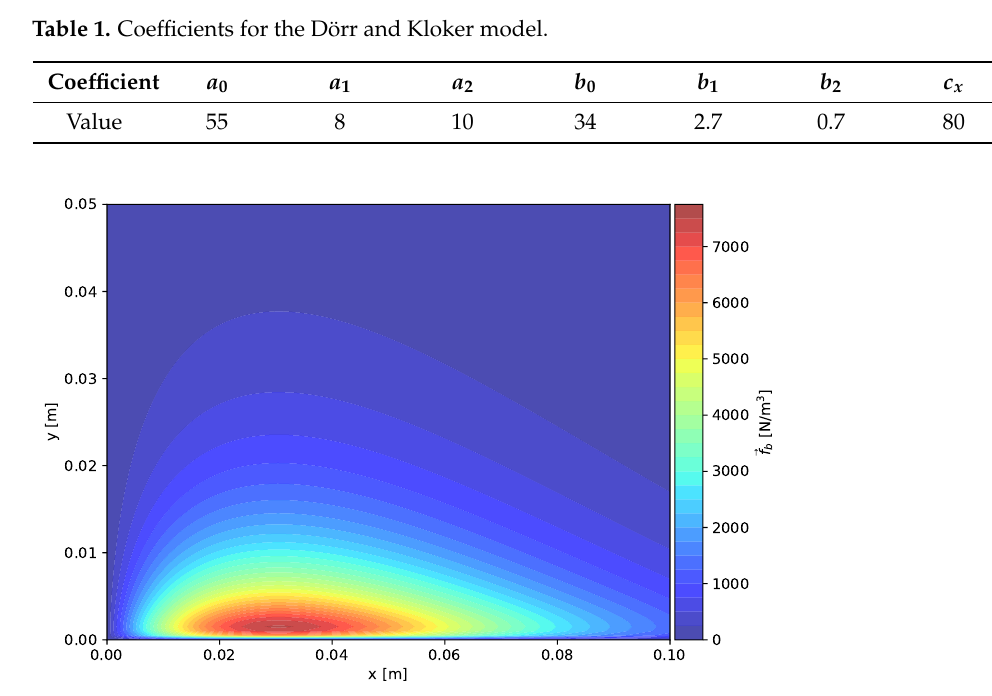
Figure 4. Nondimensional force distribution for the Dörr and Kloker